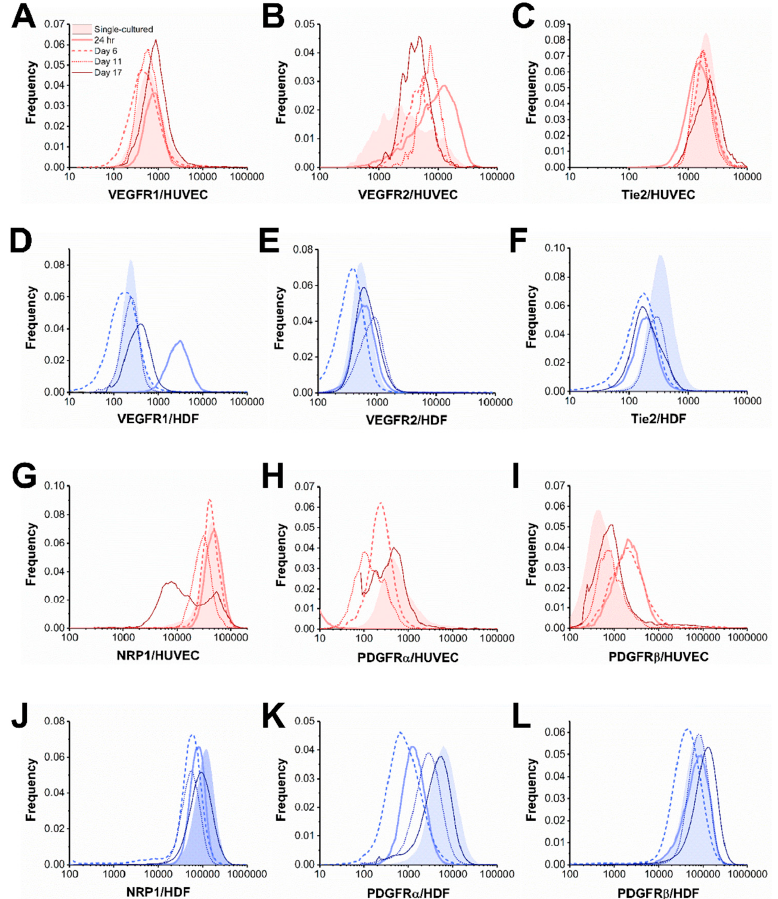
Figure 3. Cell-by-cell analysis of HUVEC–HDF coculture up to 17 days. We showed receptor distributions of ( A , D ) VEGFR1, ( B , E ) VEGFR2, ( C , F ) Tie2, ( G , J ) NRP1, ( H , K ) PDGFR α , and ( I , L ) PDGFR β on HUVECs and HDFs from co-cultures and collagenase-treated monocultures.